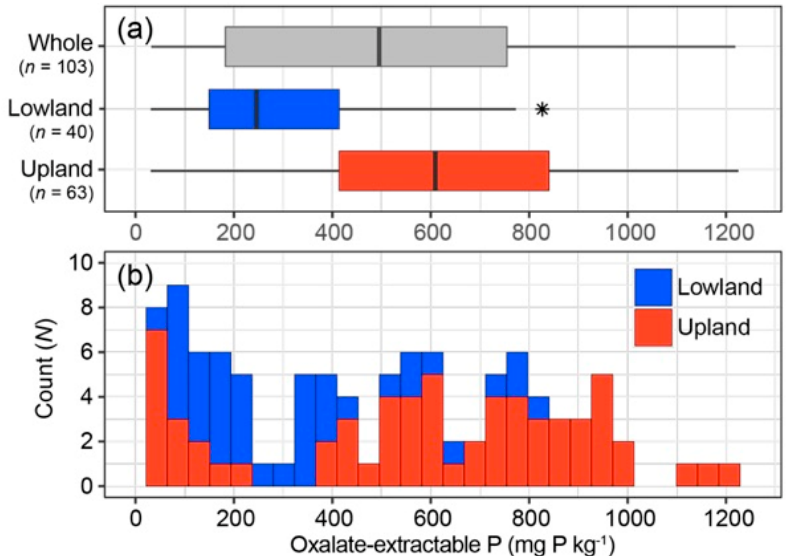
Figure 3. Box plot ( a ) and histogram ( b ) of soil oxalate-extractable P in the whole, lowland and upland data sets.